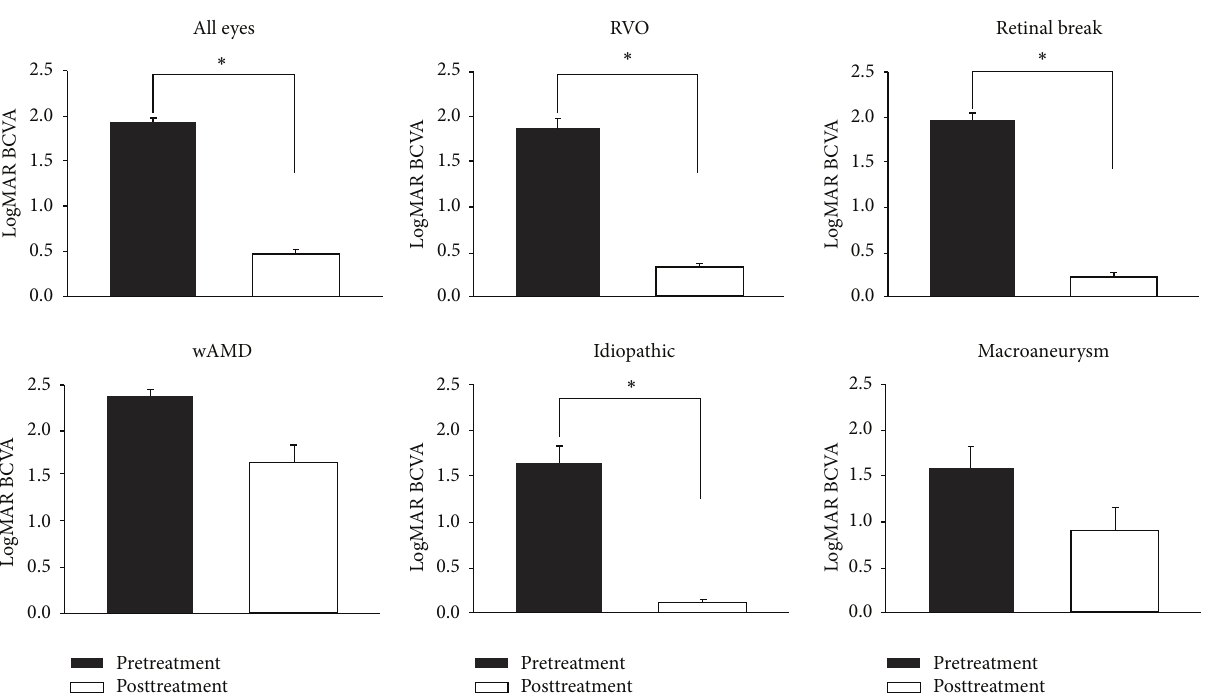
Figure 2: Changes in visual acuity after vitrectomy according to postoperative diagnosis. In the retinal vein occlusion, retinal break, and idiopathic groups, BCVA significantly improved after vitrectomy. However, visual improvement was not seen after vitrectomy among patients with wet age-related macular